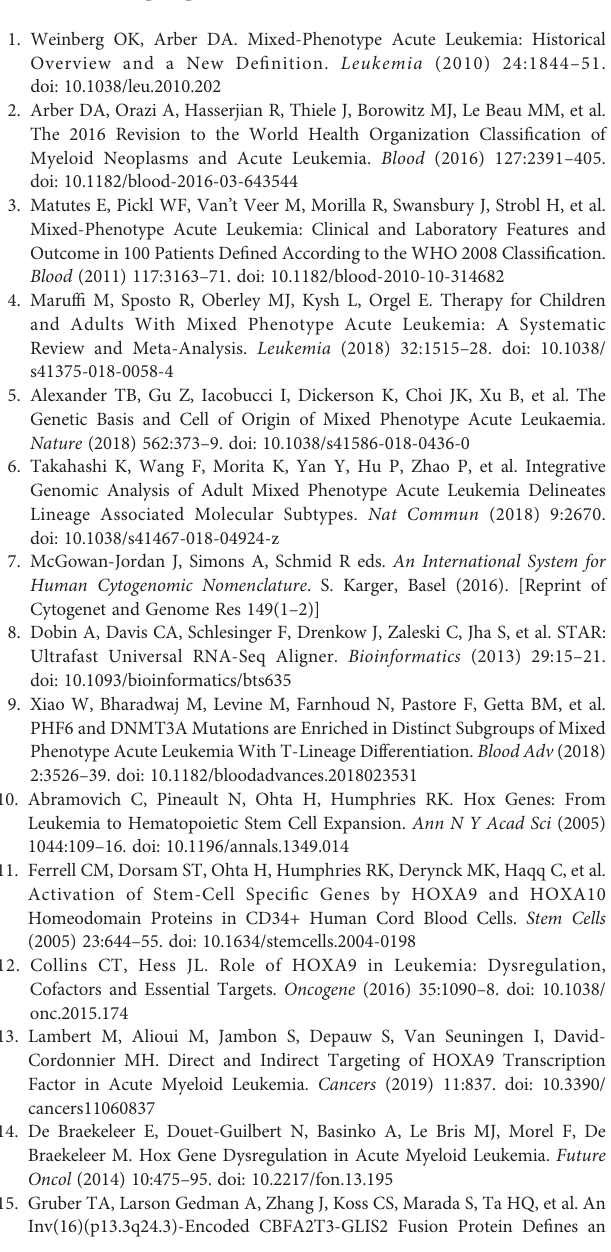
Supplementary Figure 2 | Timeline of the treatment regimens and responses. I, idarubicin; V, vinorelbine; P, prednisone; C, cyclophosphamide; H, homoharringtonine; A, cytarabine. Supplementary Figure 3 | Gene mutations and karyotype results in newly diagnostic and relapsed samples. Supplementary Table 1 | The result of RNA sequencing for MED14-HOXA9 fusion gene. Supplementary Table 2 | Clinical characteristics of the patient at diagnosis and at the time of relapse.